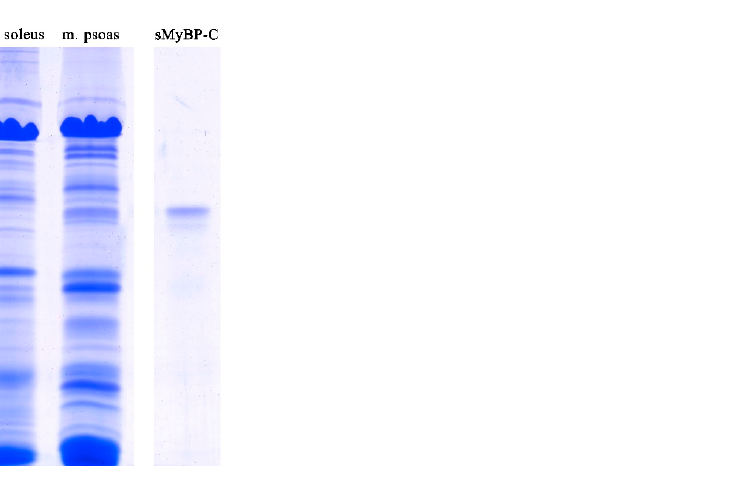
Figure 2. SDS-PAGE of purified sMyBP-C (right-hand lane). Rabbit skeletal muscles m. soleus and